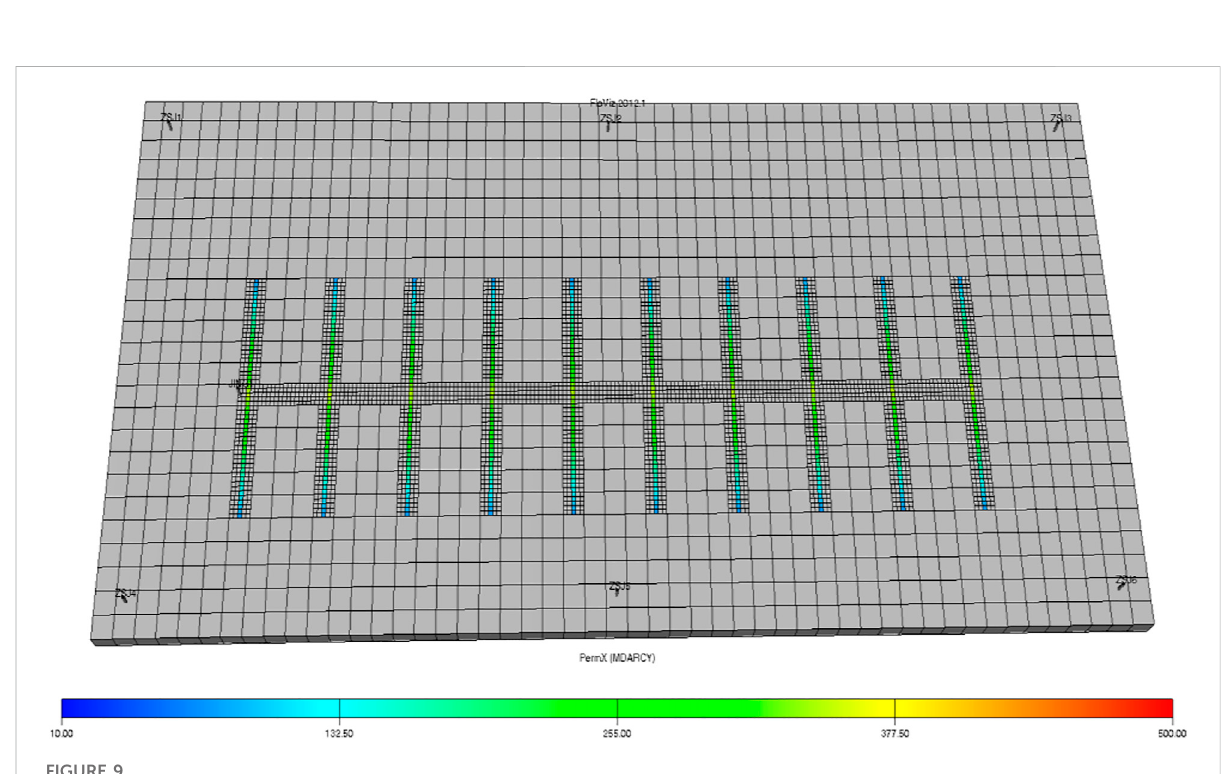
FIGURE 9 Optimization seepage model of key parameters of horizontal well volume